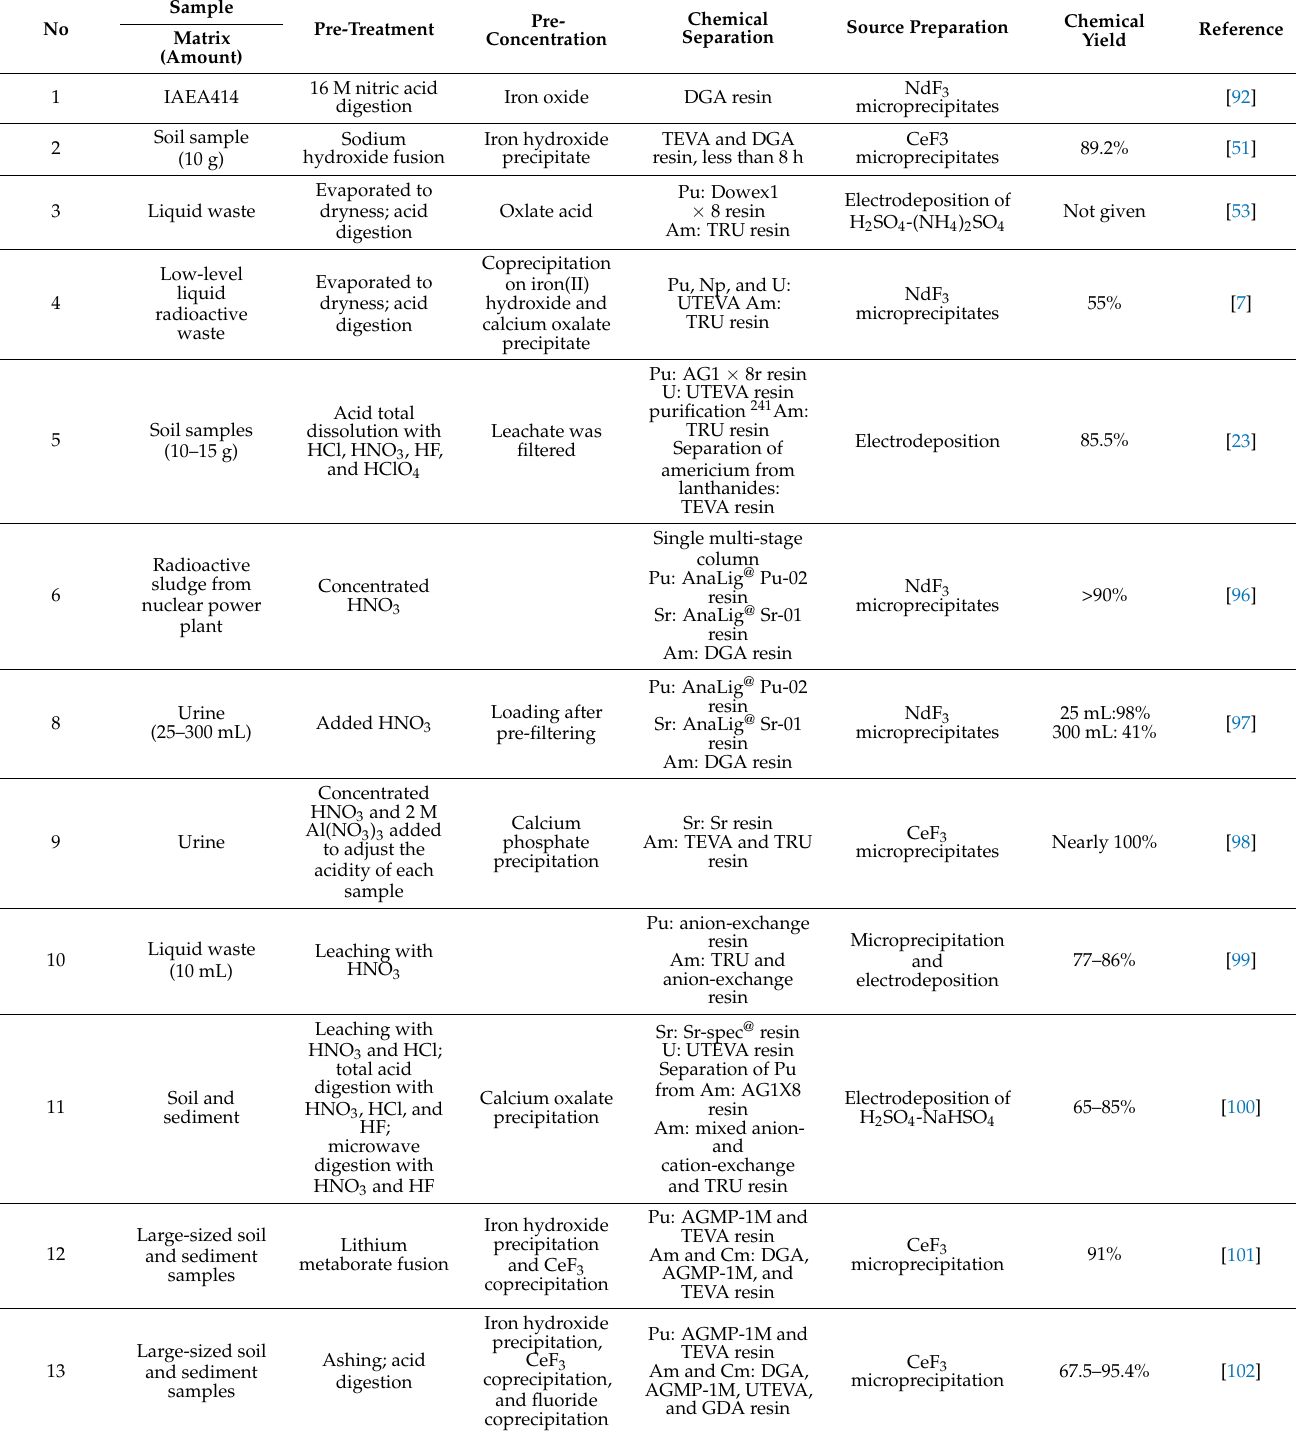
Table 6. The major parameters of combined procedures for the determination of 241 Am in environ- mental samples developed in recent